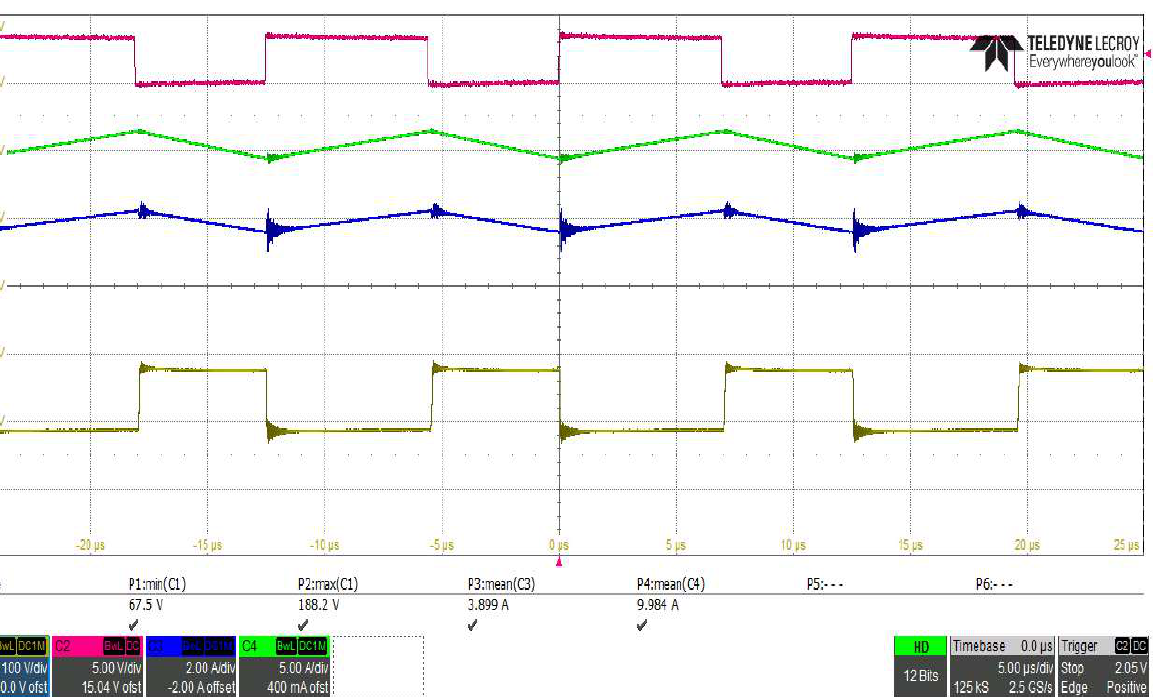
Figure 28. Experimental BHSC waveforms for step-down operation at V H = 300 V, V L = 80 V, and I L = 10 A (controlled). C1: V L2 ; C2: i L2 ; C3: V L1 ; C4: i L1 .